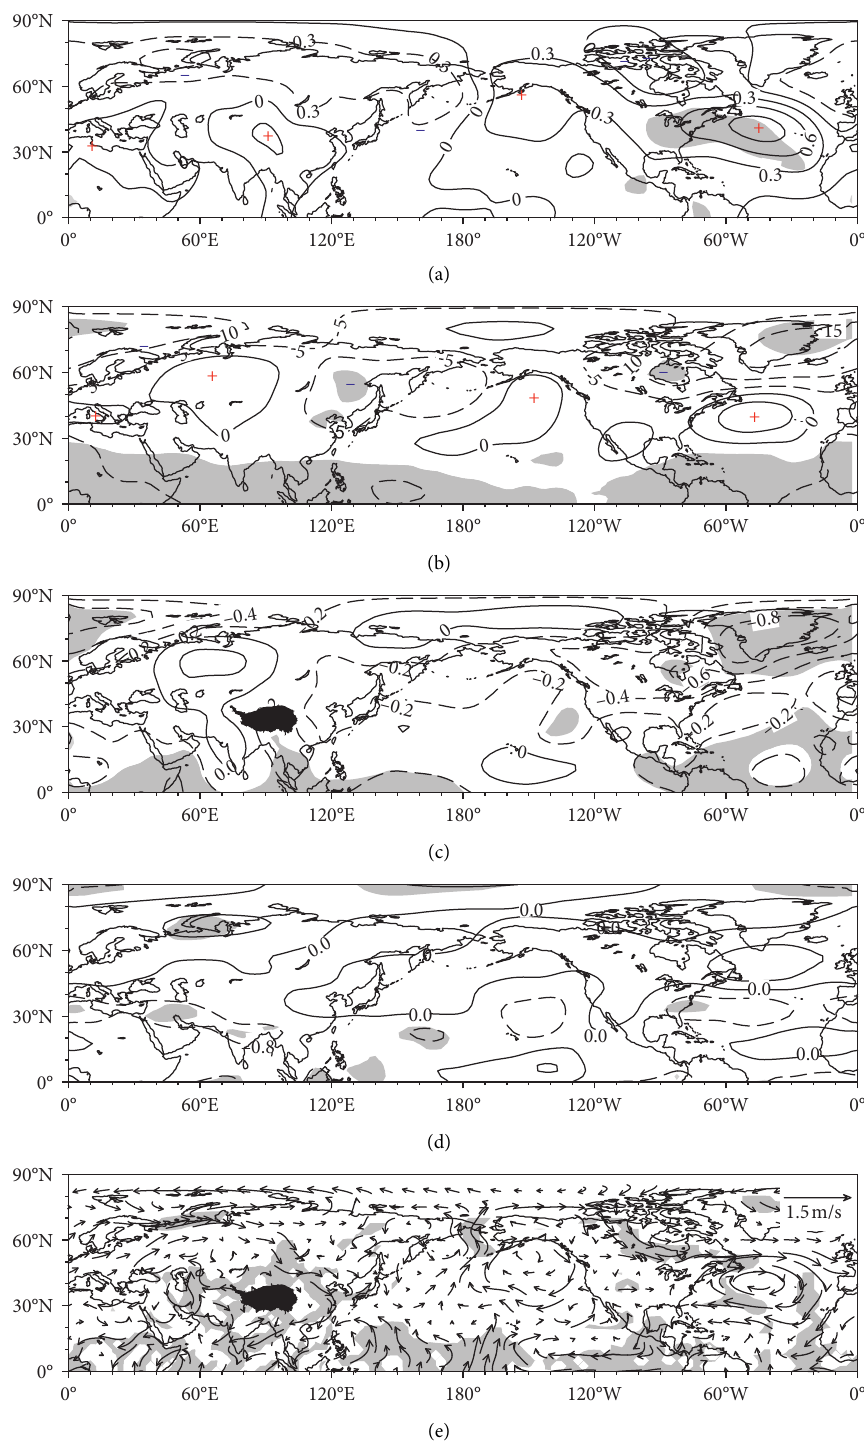
Figure 7: Linear regression coefficients of I NP in summer on the SLP field (a) unit: hPa, T 850 (b) unit: m/s, and U 200 (e) unit: m/s in winter. All values are multiplied by − 1, and shaded areas represent statistical significance at the 90% confidence level using Student’s t